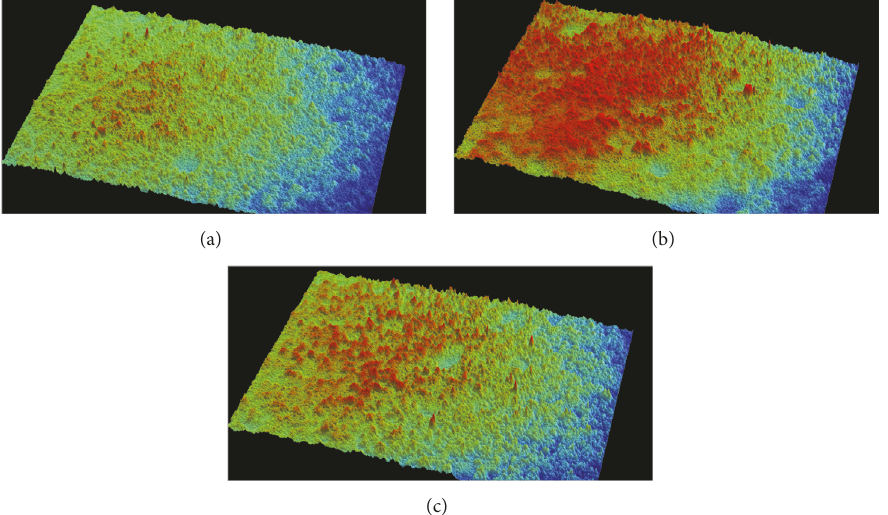
Figure 3: Representative topographic surface maps and surface analysis ( 0.317×0.238 mm) of the IonoStar Molar specimens (magnification × 20). (a) Baseline, (b) abrasive surface (control group), and (c) abrasive surface (radiant heat group).